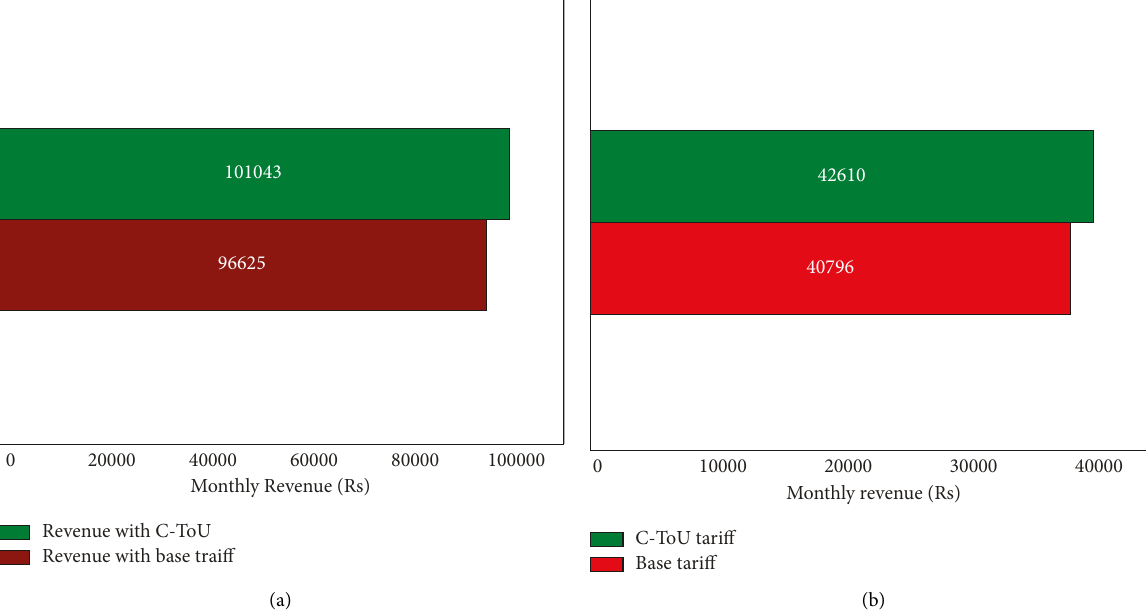
Figure 13: Comparison of utility-level monthly energy charge collection with base tariff: proposed C-ToU in (a) summer and (b) nonsummer